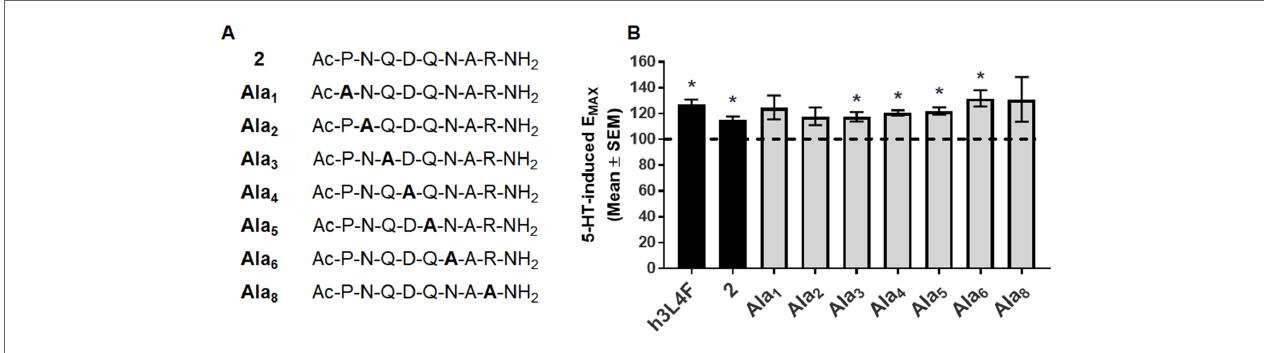
FIGURE 4 | Alanine derivatives of peptide 2 (A) were (B) tested in Ca i 2+ release assay in live h5-HT 2C R-CHO cells in the presence of 5-HT. The maximum 5-HT-induced Ca i 2+ release in the absence of the compounds was set as 100% (dashed line). Bars represent the average E MAX produced by 1 nM alanine derivative in the presence of 5-HT, shown as mean ± SEM of 4–5 biological replicates. * p < 0.05 vs. 5-HT alone (dashed